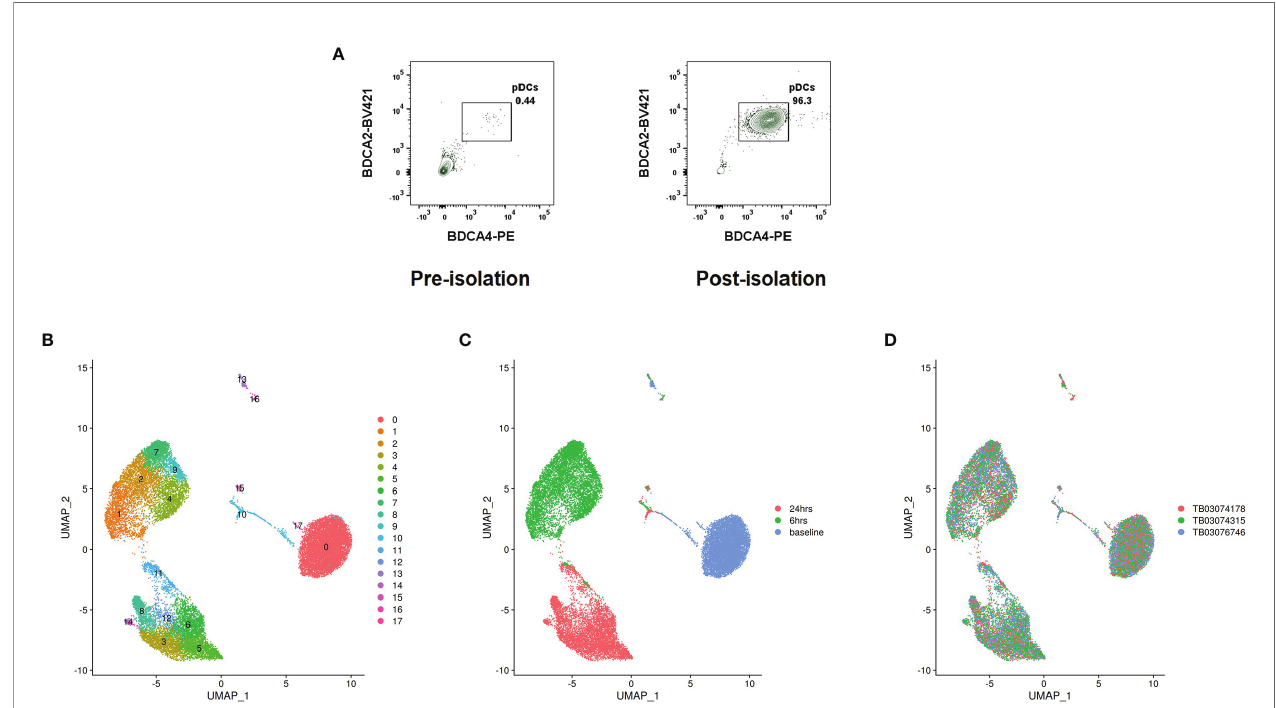
FIGURE 2 | pDC heterogeneity determined by scRNA-seq. (A) Representative pre- and post-pDC isolation purities. Data represent ungated PBMCs stained for the pDC markers BDCA4 and BDCA2. (B) Cell clusters identi fi ed by Seurat. (C) Cells colored by time point at partitioning. (D) Cells colored by